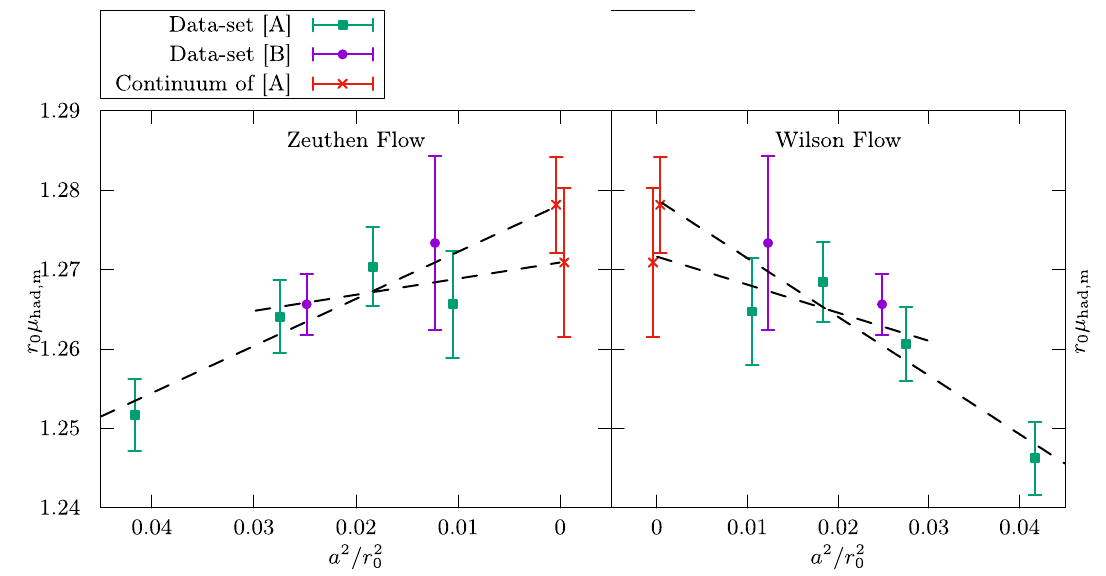
Fig. 9 Continuum extrapolations of r 0 μ had , m using the data set [A] [60] and the results of Table 5. For illustration, the two points of data set [B] [59] in the range of β covered by the finite volume simulations